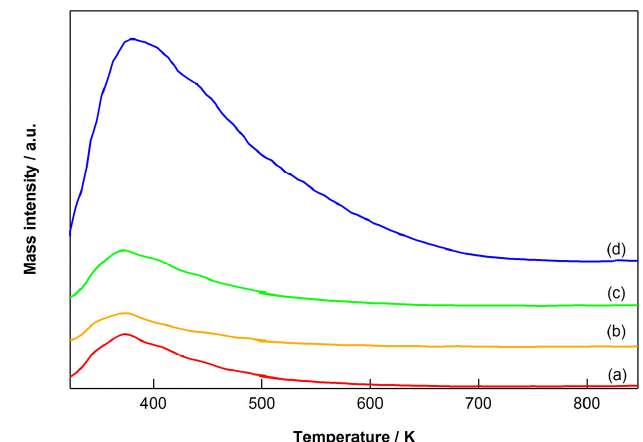
Figure 7. Temperature-programmed desorption of carbon dioxide profiles of ( a ) 5%ZrO 2 –Al 2 O 3 ,